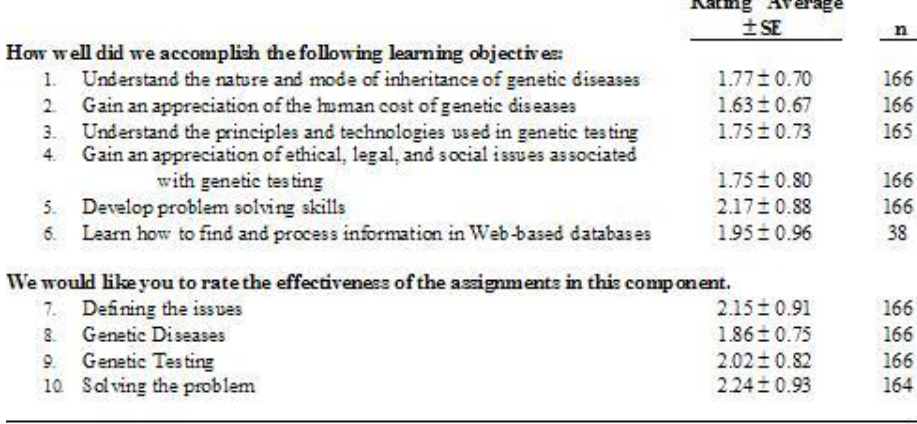
Table 3. Student evaluation ratings in response to the problem-based learning unit in an online biotechnology class. Ratings are based on a scale of 1 (excellent) to 5